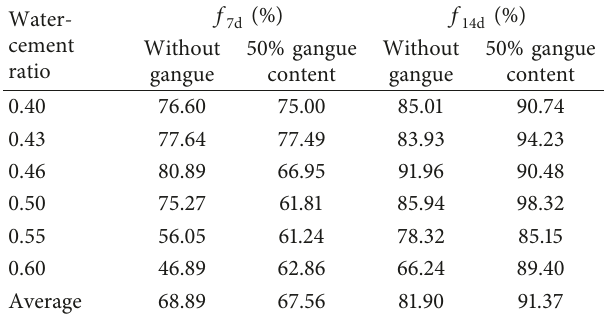
Table 3: Strength development degree of the early age gangue concrete.